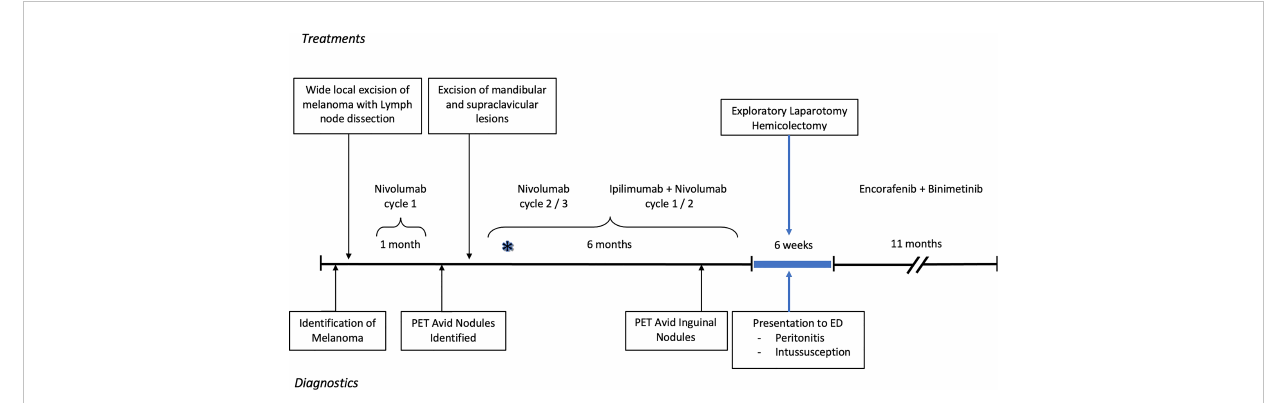
FIGURE 1 Timeline of diagnostics and treatment of melanoma and subsequent severe colitis resulting in surgery. The asterisk re fl ects when the patient fi rst noticed colitis symptoms. The PET, positron emission tomography; ED, Emergency